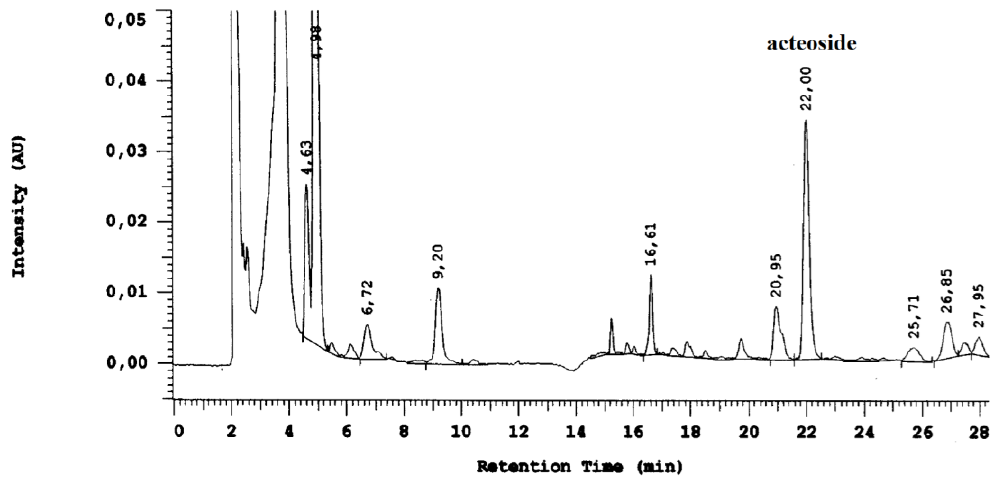
Figure 2. High-performance liquid chromatography chromatogram of the finished product “ Plantago syrup” .